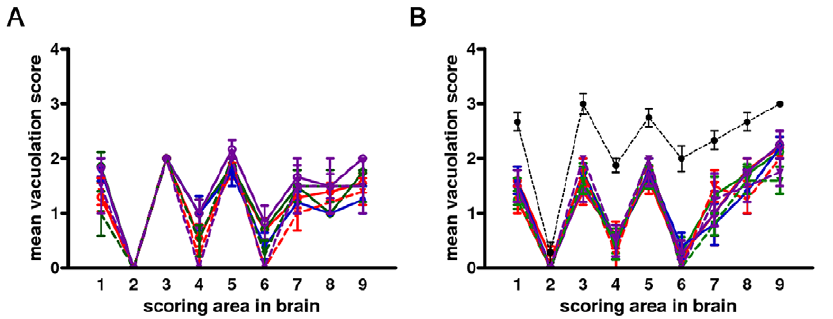
Figure 2. Lesion profiles of Bv109I infected with CWD following primary transmission and third passage. Pathological phenotypes observed after primary transmission and third passage are shown in (A) and (B), respectively. CWD1, 2 and 4 from elk, are shown in red, green and violet lines with open circles, respectively; CWD3 from mule deer, in blue line and closed circles; CWD5, 6 and 7 from W-T deer in red, green and violet dashed lines and closed triangles, respectively. Vole-adapted sheep scrapie is shown in black dashed line and closed circles. Brain-scoring areas are: medulla (1), cerebellum (2), superior colliculus (3), hypothalamus (4), thalamus (5), hippocampus (6), septum (7), retrosplenial and adjacent motor cortex (8), cingulate and adjacent motor cortex